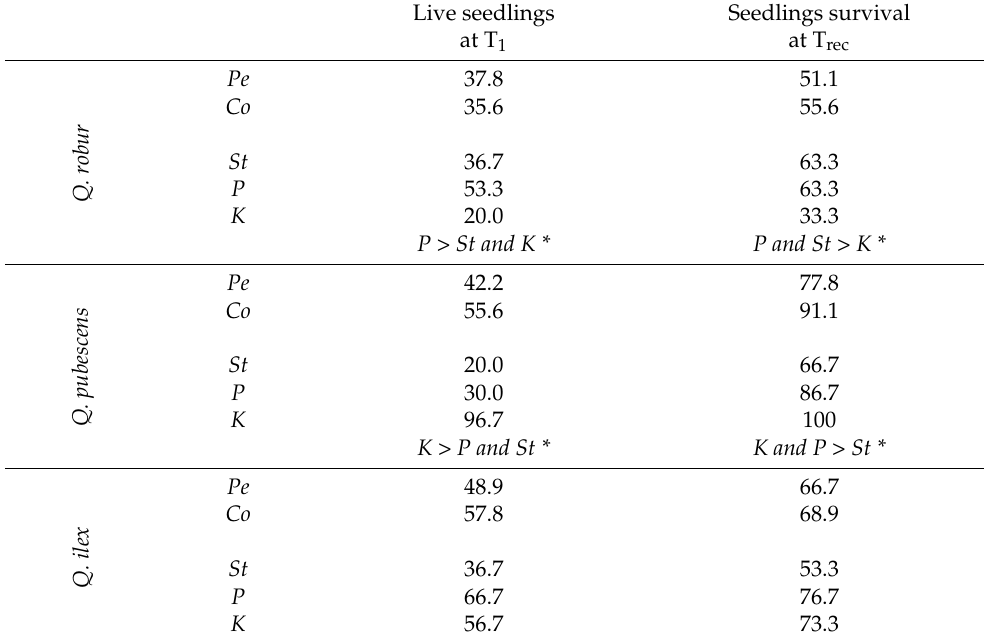
Table 2. Live seedlings at T 1 (no dry shoot) and survival at T rec (data in %) of Quercus species after transplanted in controlled conditions under high water stress. Pe , Co : peat and coir substrate; St , P , K : standard, P- and K-enriched fertilization. T 1 : end of the water stress experiment, T rec : recovery. * couples comparisons by Chi-square test performed when GLM model results for fertilization were significant.